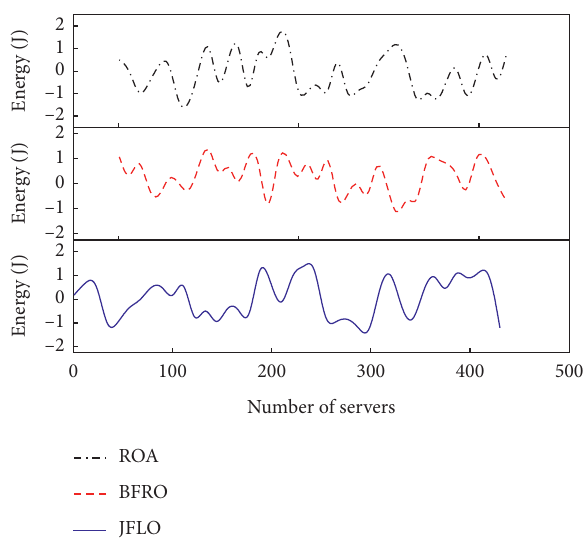
Figure 5: Graph of energy consumption with the number of MEC servers.